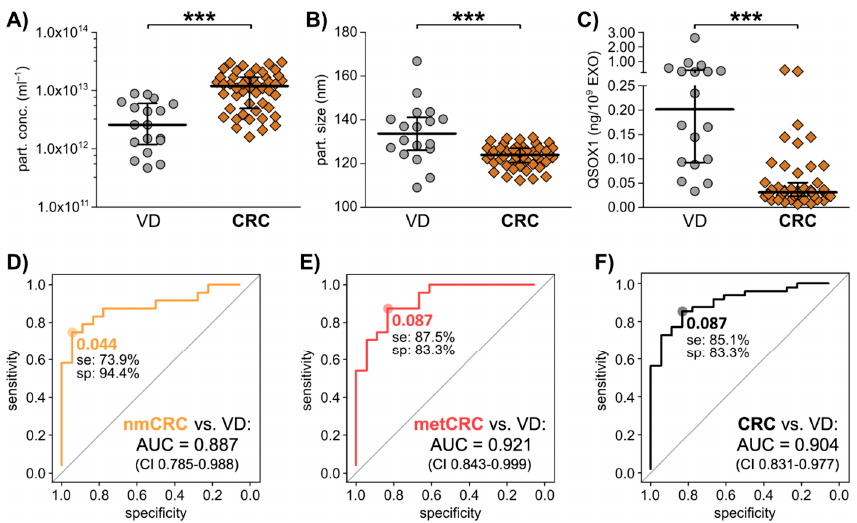
Figure 5. The potential of pEXO QSOX1 as early diagnostic biomarker in CRC liquid biopsy. Blood samples of 48 independent CRC patients were collected immediately prior to surgery, and plasma was subjected to EV isolation. 18 VD patients were analysed as control. ( A ) Particle concentration and ( B ) size of isolated plasma EXOs, examined by NTA analysis using ZetaView ® . ( C ) Exosomal QSOX1 protein content in the two patient groups as measured by ELISA. Mann-Whitney-U test: *** p < 0,001. ( D–F ) Diagnostic ROC curve analysis of pEXO-QSOX1, comparing non-metastatic CRC (nmCRC, D ), metastatic CRC (metCRC, E ) and all CRC patients ( F ) vs. VD patients. Optimal cut-off values reflecting highest sensitivity (se) and specificity (sp) were calculated by Youden Index.